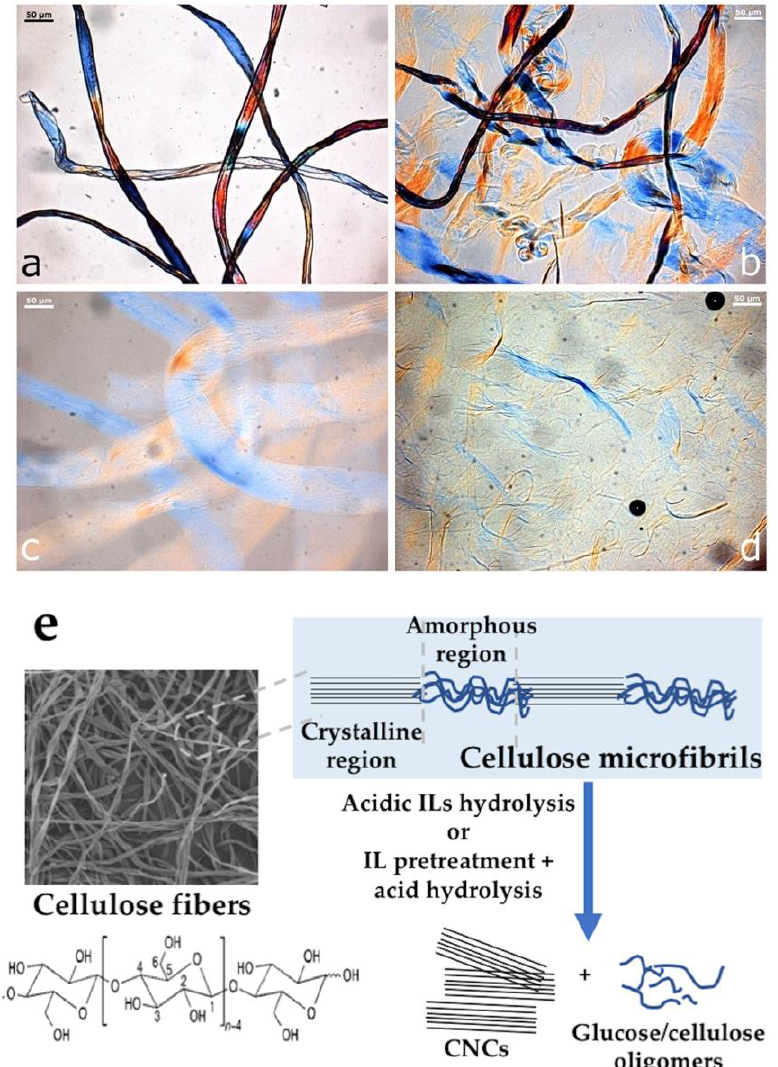
Figure 4. Morphologies of cotton fibers observed by optical microscopy during IL treatments: native cellulose fibers ( a ), partial and advanced swelling ( b , c ), destructuring into fibrils in [BMIM]Cl/[BMIM]HSO 4 ( d ) (reprinted with permission from [39]). Schematic isolation of CNCs from cellulose fibers by hydrolysis in ILs ( e ) (an SEM image of cotton fiber from authors ’ own work).